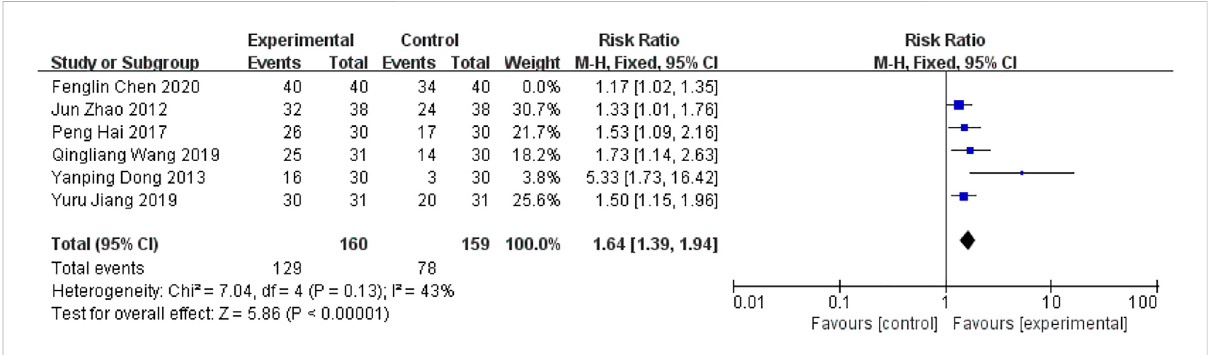
FIGURE 12 Forest plot of clinical ef fi cacy for Chinese medicine excluding Chen.